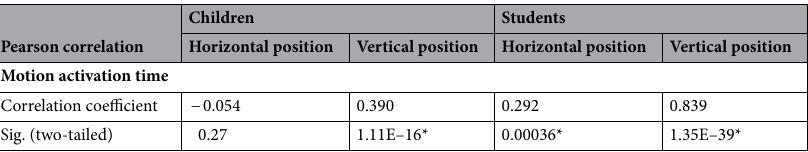
Table 5. Correlation results between motion activation time and horizontal/vertical position of children and students. *at 0.01 level (two-tailed), the result is significant.